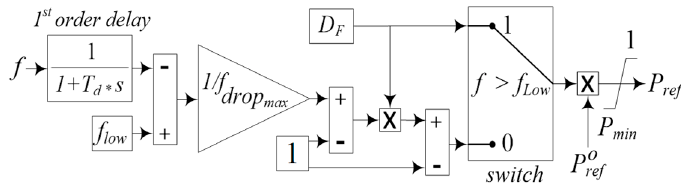
Figure 3. Block diagram of the implemented droop pitch deloading.